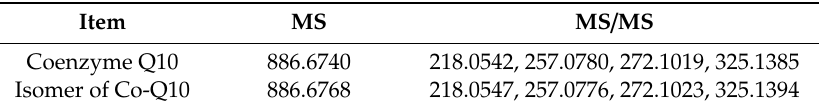
Table 2. Co-Q10 reference substance and impurity X primary mass spectrometry and secondary mass spectrometry data.